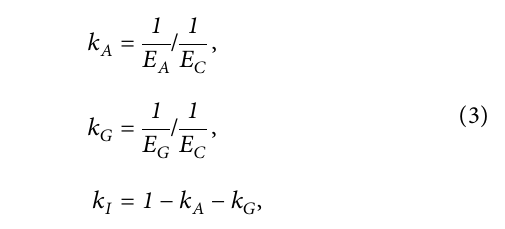
Figure 4: PAV tubes filled with plastic